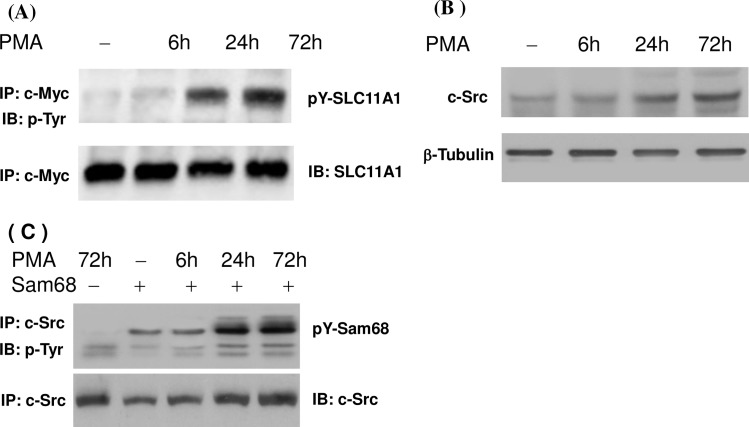
Effect of PMA treatment on the tyrosine phosphorylation of SLC11A1 and Src kinase activity.U937-SLC11A1 cells (stably expressing SLC11A1-c-Myc fusion protein) were left untreated or treated with PMA (10ng/ml) for 6, 24 and 72 hrs. (A) Cell lysates were immunoprecipitated with an anti-c-Myc antibody (9E10). The phosphorylation levels of SLC11A1 were analyzed by immuoblotting with an antibody to phosphotyrosine (4G10). The same blots were reprobed with an anti-SLC11A1 antibody. (B) Cell lysates were separated on SDS-PAGE and the expression of c-Src protein was detected by Western blot analysis. The blots were stripped and re-probed with an antibody against β-tubulin as a loading control. (C) Cell lysates were immunoprecipated with a specific antibody against c-Src. In vitro kinase activity assay was performed using Sam68 as a substrate (top panel). The immunoprecipitates were also probed with a specific anti-c-Src antibody (bottom panel).